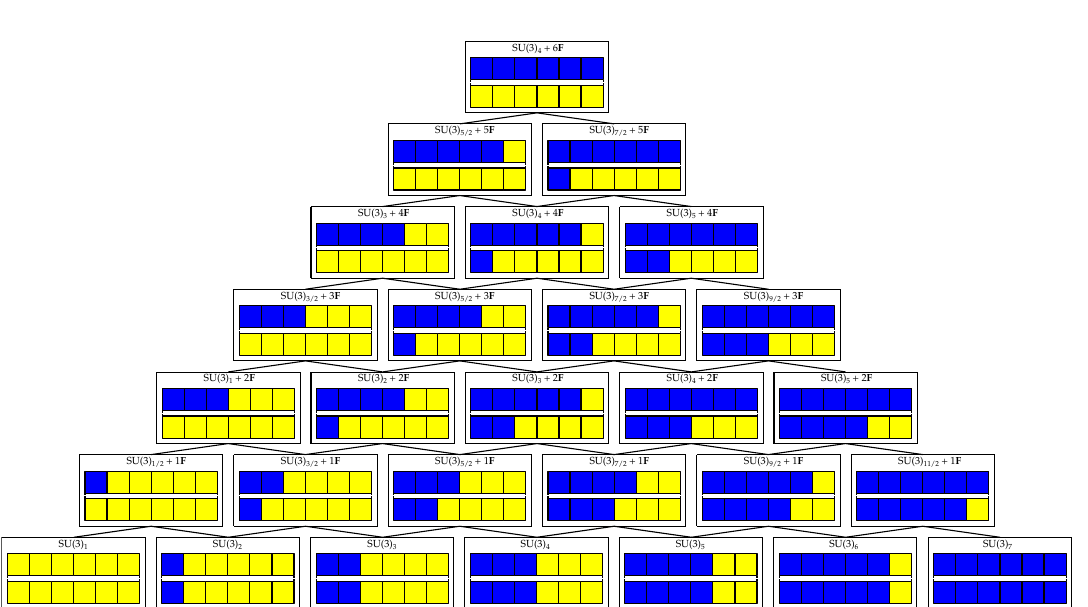
Figure 36. The tree of descendants for SU(3) 4 + 6 F , which is gauge theory description for the marginal theory obtained from SU(3) on a ( (cid:0) 1)-curve with 12 hypermultiplets.